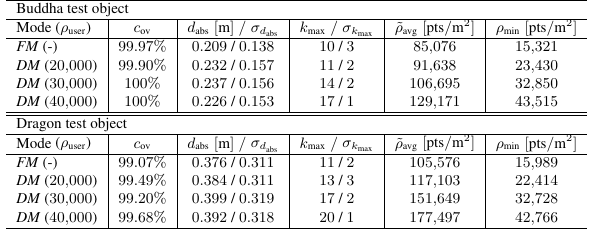
Table 2. Results for the Buddha test object (top) and the Dragon test object (bottom): the tables show the E P and the minimal point density ρ min listed by the modes, for three different user densities in the DM . Mode ) is averaged over 10 runs. The next four columns are the evaluation parameters from Section 3.4. Provided that the theo- retical maximum for c ov is 100% , for d abs is the lower the better and for k max also the lower the better. The average point den- sity ˜ ρ avg is calculated by Equation 8. In addition, we show the standard deviation of k max to see the variance and the minimal reached point density ρ min which have to be higher than ρ user in the DM . The same test was done for the Dragon object, the re- sults are shown in Table 2 (bottom). The hyperparameters were the same for both test